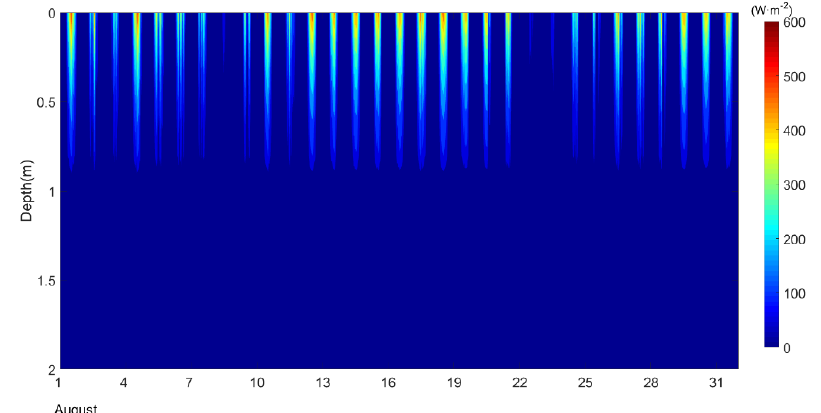
Figure 5. Solar radiation received at different lake depths in the E- ε model.